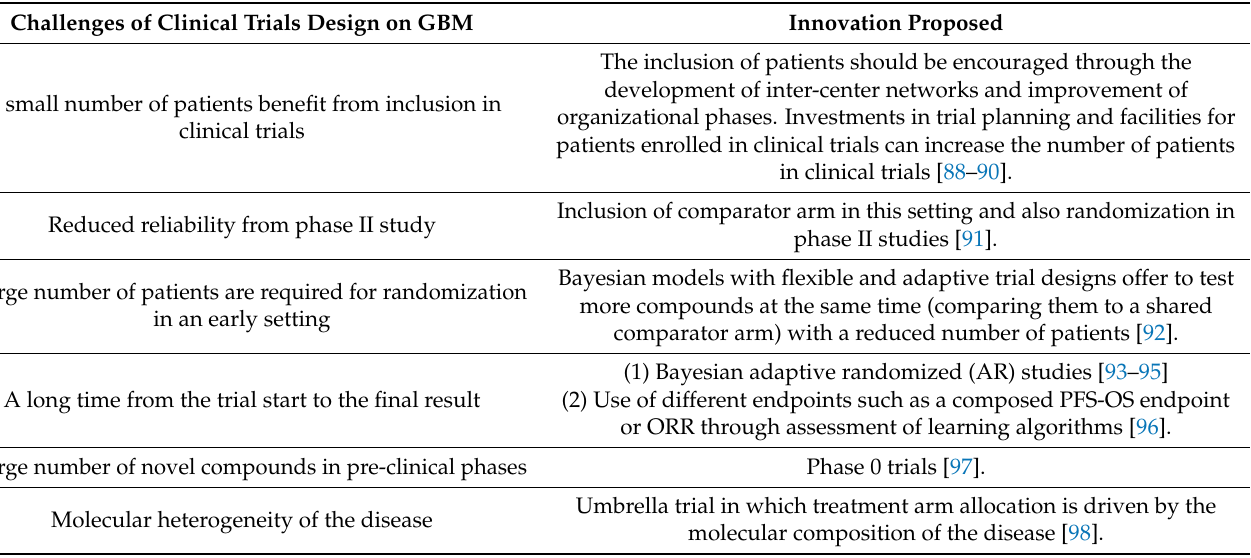
Table 2. Challenges and innovations of trial design planning for patients with glioblastoma. Challenges of Clinical Trials Design on